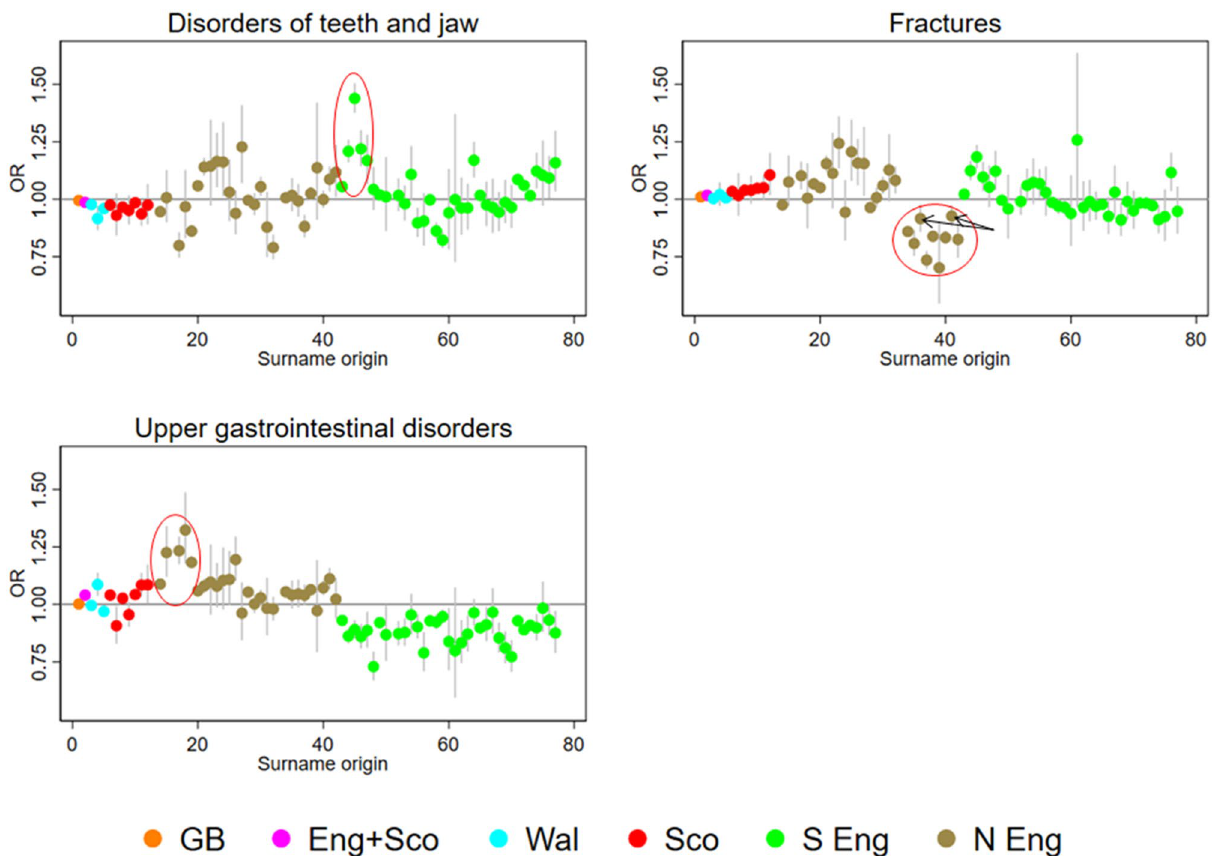
Figure 2. Hospital admission risk by surname origin for four disease-origin branch signals. The x-axis has the order of each surname origin in the dendrogram shown in Fig. 1 putting each “branch” next to its distal sub- branch. Arrows indicate 2 origins in the Fractures signal that would only be significant at a FDR >